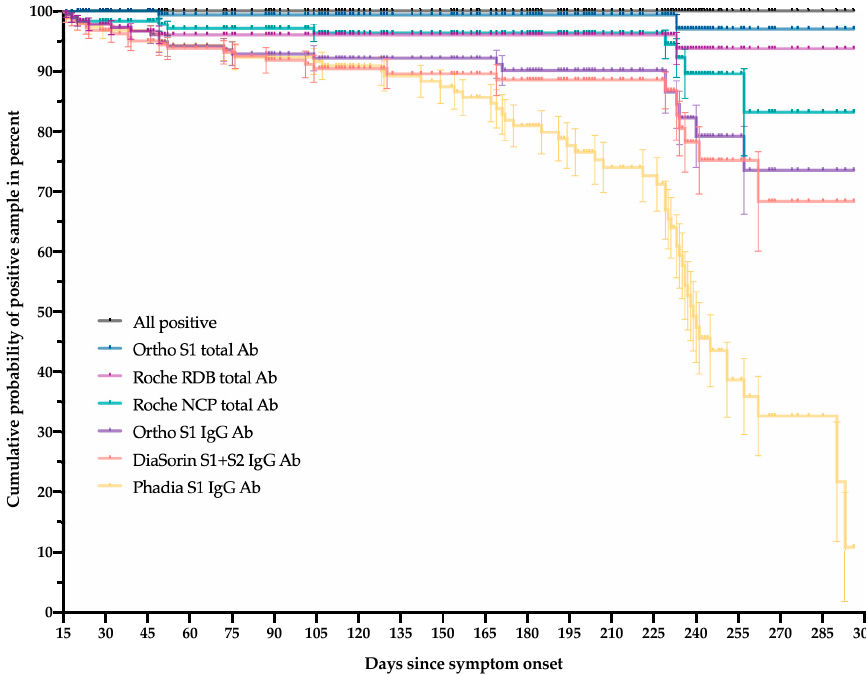
Figure 2. The cumulative probability of positive samples after 14 days until the last follow-up point, i.e., 300 days, using six different commercial assays.